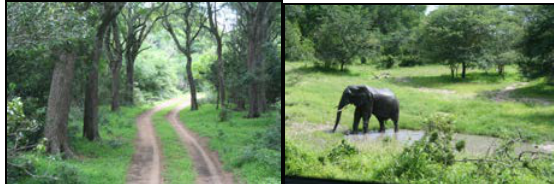
Figure 3: Tembe Elephant Park (Source M Jordaan, 2011)